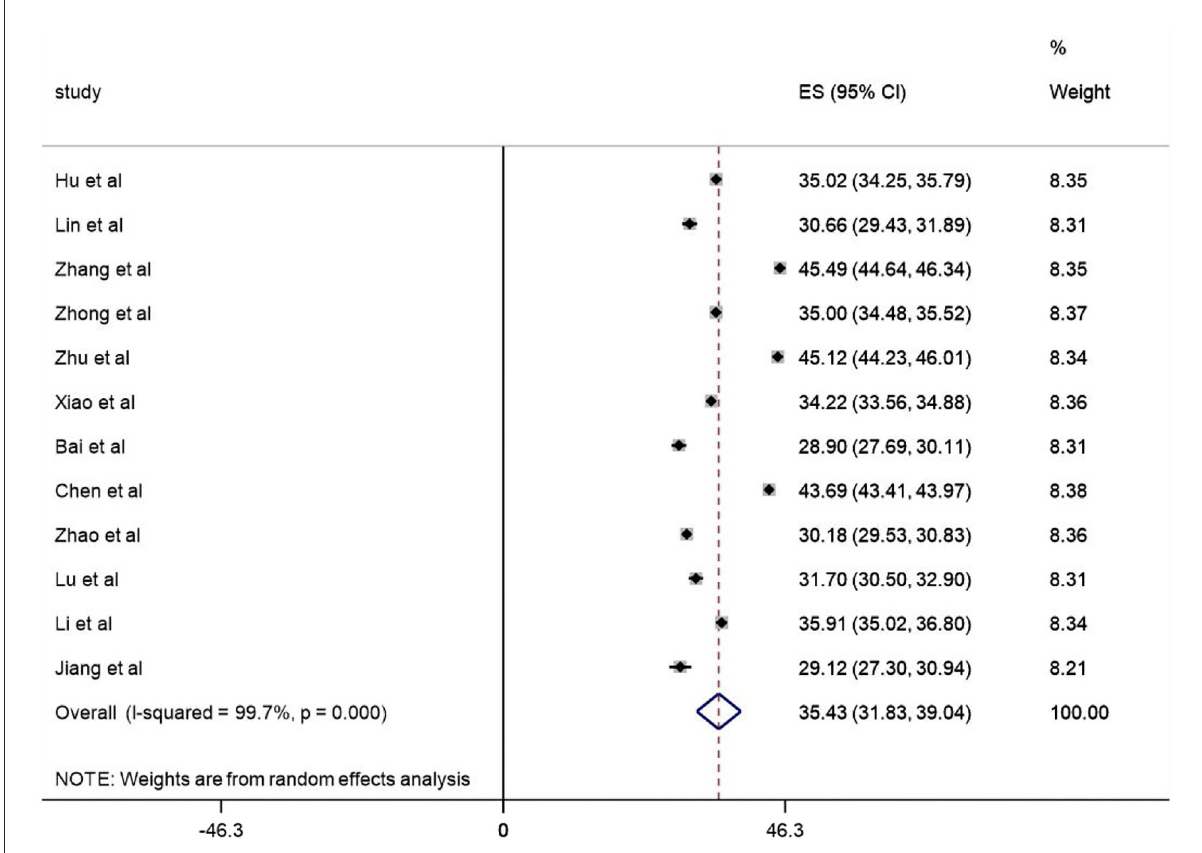
FIGURE2 Forest plot of prevalence of